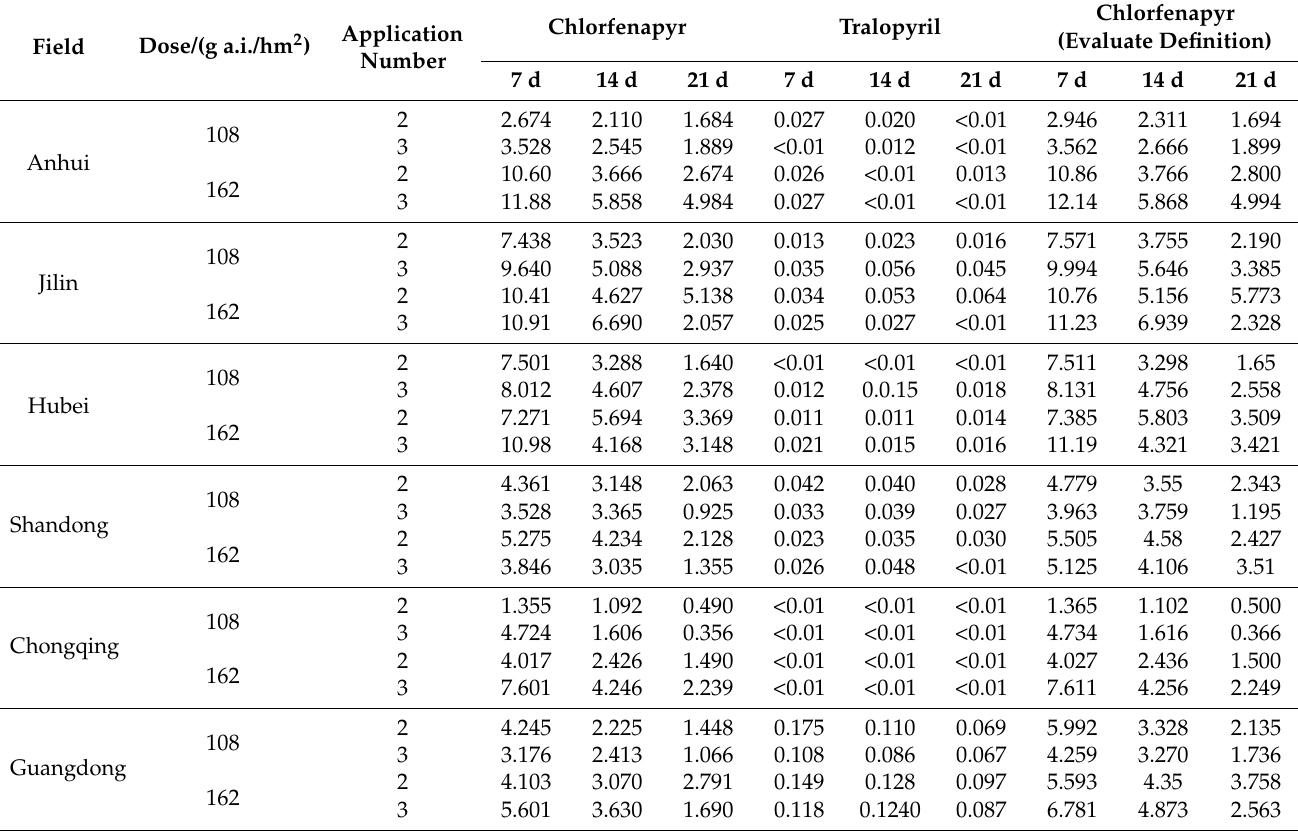
Table 4. Final residues of chlorfenapyr and tralopyril in radish